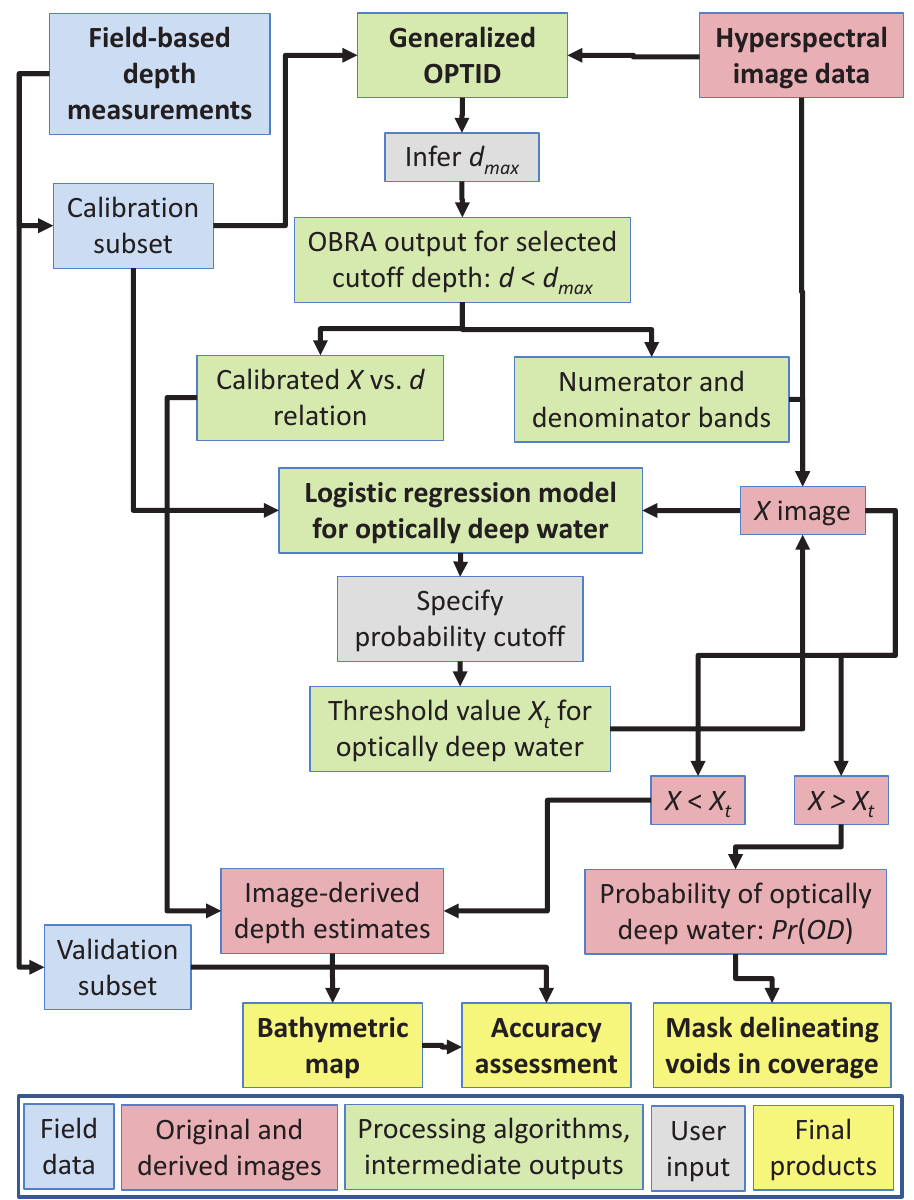
Figure 2. Conceptual diagram of the bathymetric mapping workflow. Field-based data are represented in blue, original and derived images in red, processing algorithms and intermediate outputs in green, user inputs in gray, and final products in yellow. The key components of the workflow are highlighted with a bold